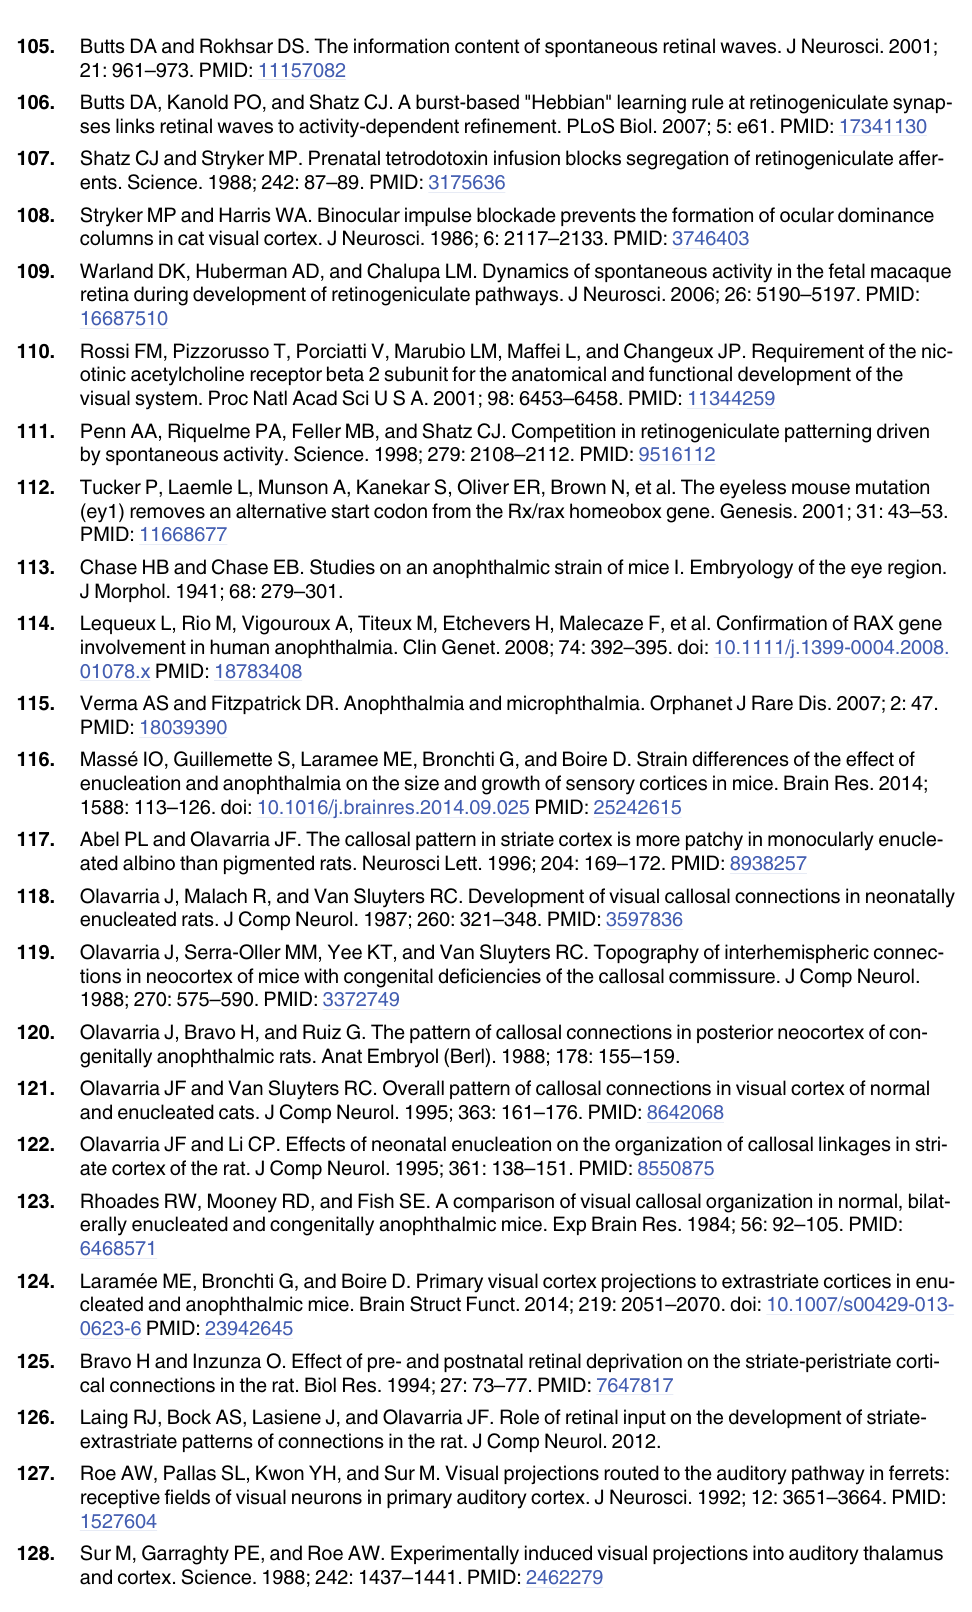
PLOS ONE | DOI:10.1371/journal.pone.0159320 July 13,